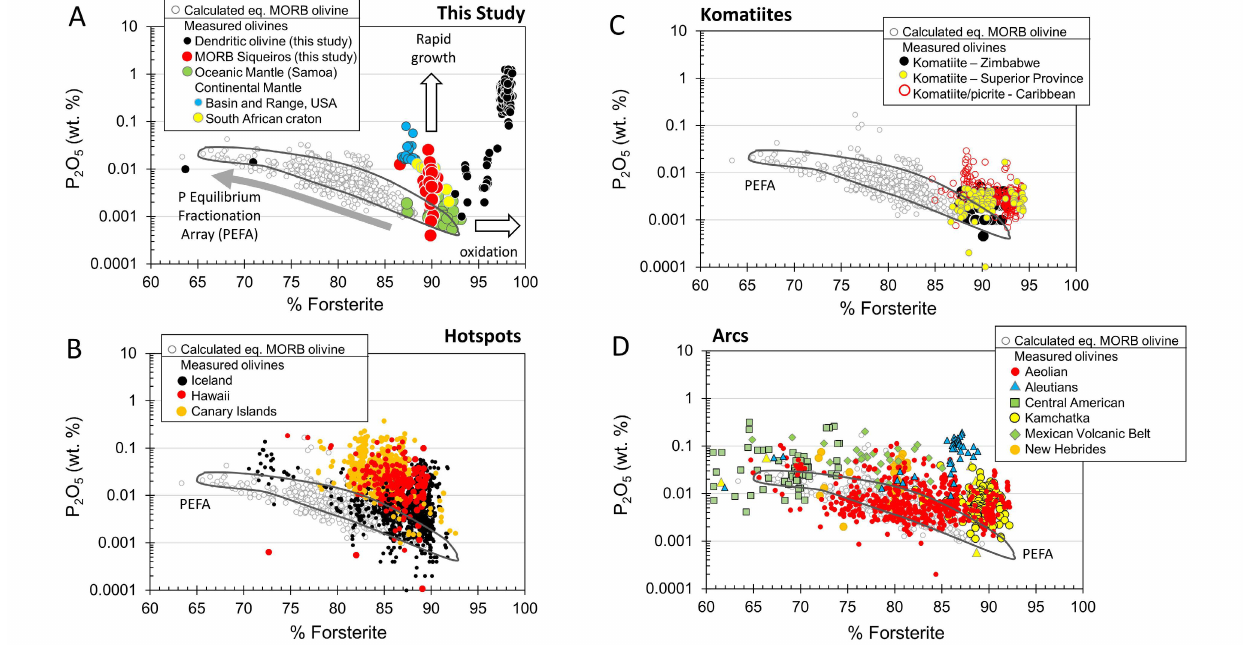
Figure 6: Olivine P O concentration versus forsterite content (atomic Mg/(Mg+Fe)×100). [A] Results of this study and that of He 2 5 et al. [2019]. Black symbols represent dendritic olivine phenocrysts from Kaua ‘ i and red symbols represent olivine phenocrysts from Siqueiros MORB glass investigated here. Also shown are olivines from mantle xenoliths representing oceanic lithospheric mantle (Samoa oceanic island) and continental lithospheric mantle (Phanerozoic Basin and Range in USA and Archean Kaapvaal Craton in southern Africa) from He et al. [2019]. Open gray circles represent calculated olivine compositions in equilibrium with MORB glass compositions from global compilation of Jenner and O’Neill [2012]. Equilibrium olivine compositions calculated assuming a temperature-corrected P partition coefficient (see text). The array of equilibrium olivine compositions is outlined and defined as the Phosphorous Equilibrium Fractionation Array (PEFA); gray arrow shows direction of differentiation. Horizontal white arrows show direction of oxidation. Vertical white arrow shows direction of rapid growth. The unique spinifex olivines from Kaua ‘ i can be explained by rapid crystal growth under oxidizing conditions. [B] Olivine phenocryst compositions from basalts from Iceland, Hawai ‘ i and the Canary Islands. All other symbols as in [A]. [C] Olivine phenocrysts from Archean (Zimbabwe and Superior Province) and Phanerozoic (Gorgona) komatiites. All other symbols as in [A]. [D] Olivine phenocrysts from various arc magmas. All other symbols as in